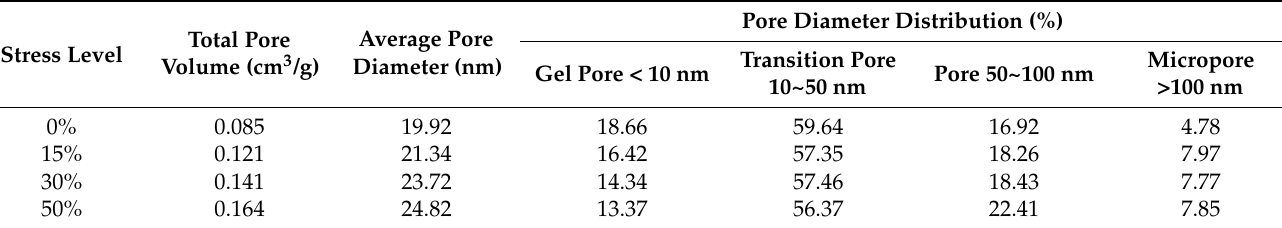
Table 3. Influence of bending load on the pore structure of the hardened